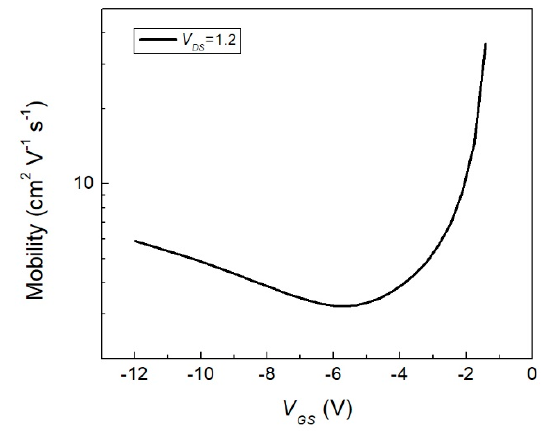
Figure 12. Linear mobility characteristics as function of the gate bias.